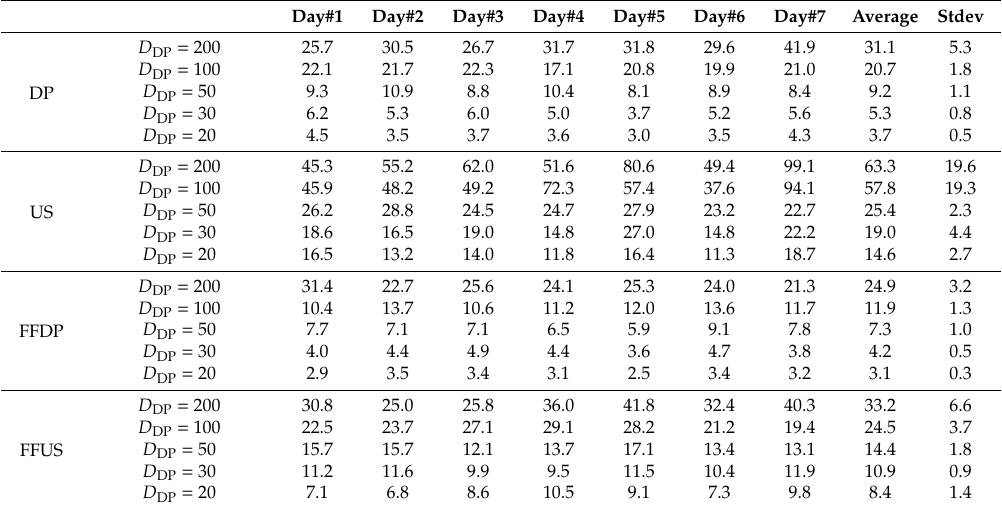
Table A1. Comparison of average PED of di ff erent simplification scheme.